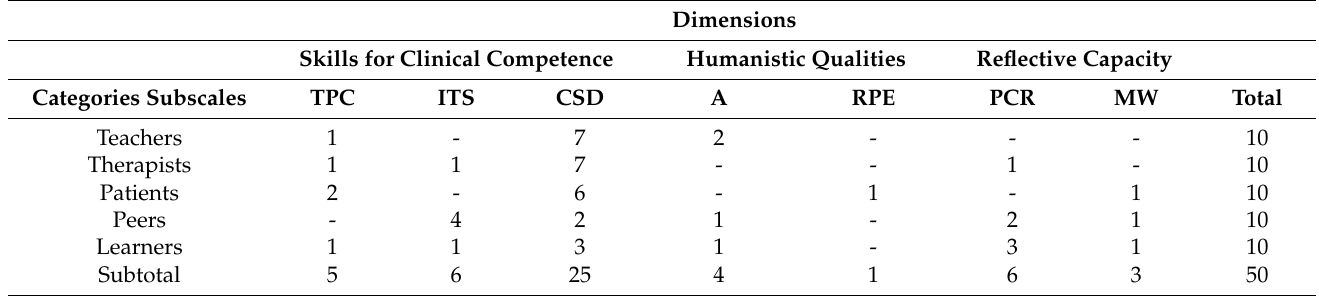
Table 4. Blueprint of the MPC items: subscales, dimensions, and categories. Dimensions Skills for Clinical Competence Humanistic Qualities Reflective